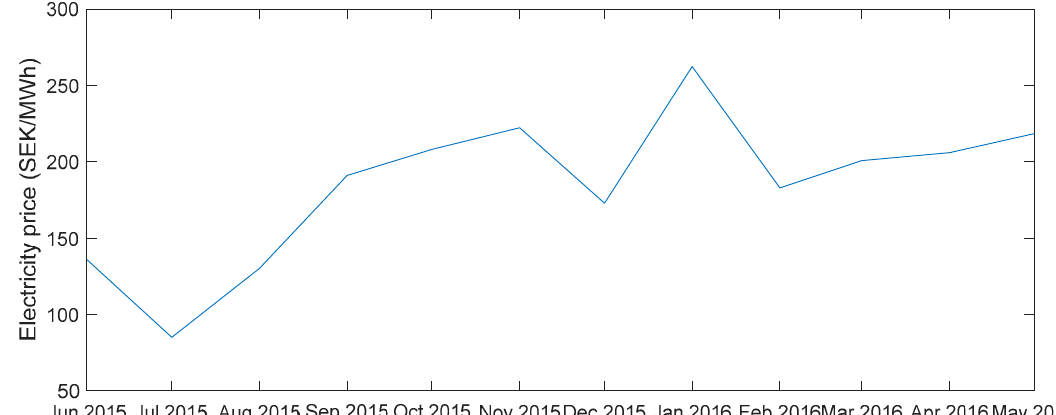
Figure 18. Monthly average electricity price [34].